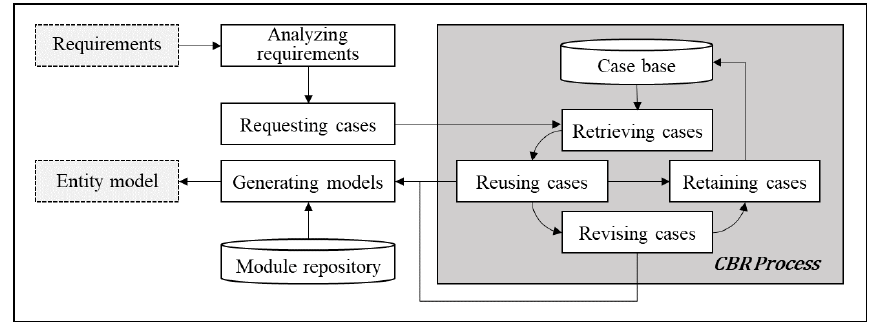
Figure 4. Intelligent modeling process using case-based reasoning.